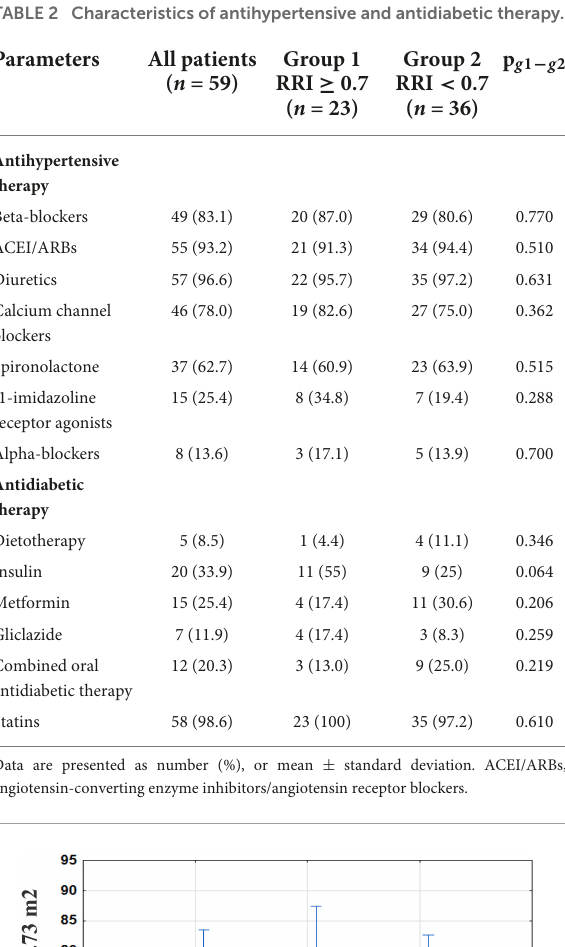
TABLE 1 Clinical characteristic [M ± SD, n (%)]. TABLE 2 Characteristics of antihypertensive and antidiabetic therapy.